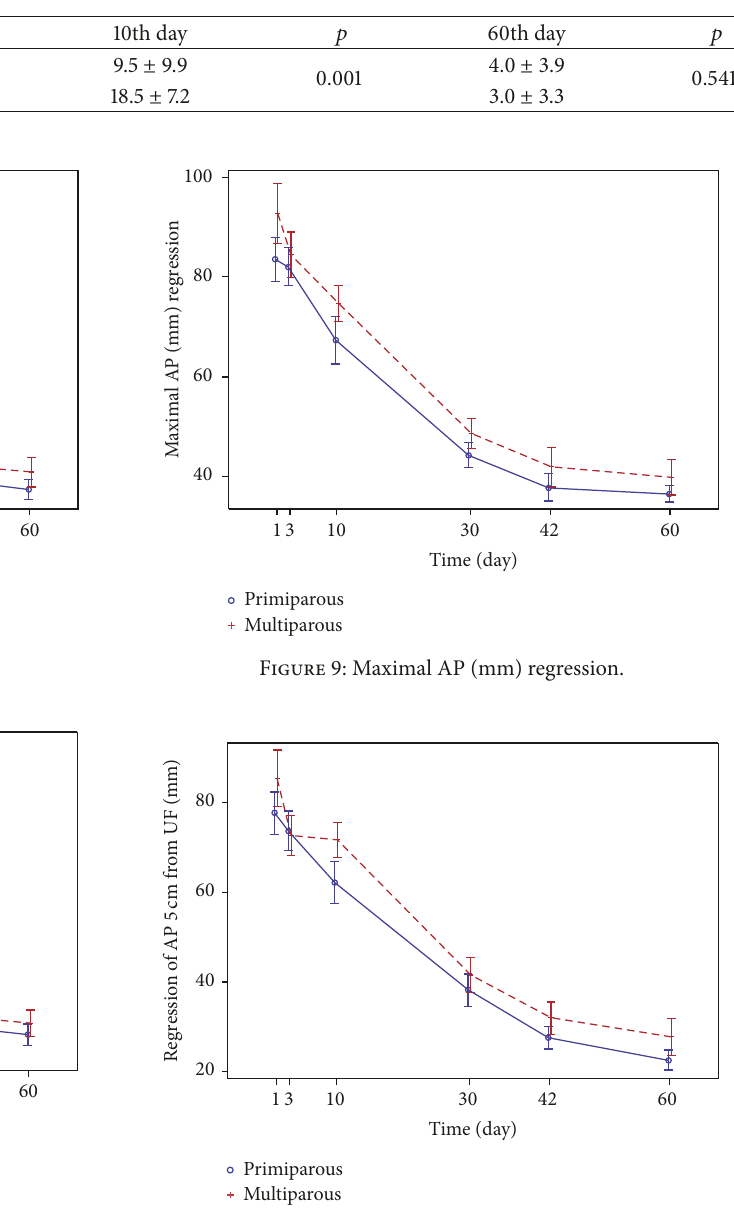
Table 3: Changing of the widest part (median values ± standard deviation) of the uterine cavity (mm).